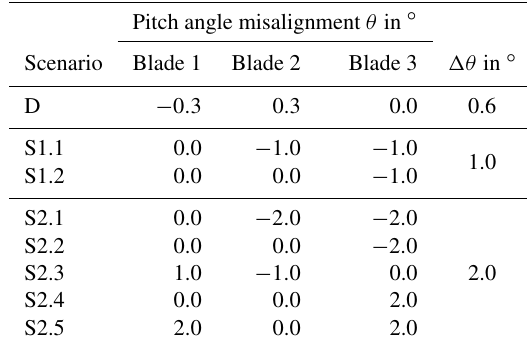
Figure 5. Aerodynamic imbalance derived from the measurement data set. Table 1. Imbalance scenarios simulated. Pitch angle misalignment θ in ◦